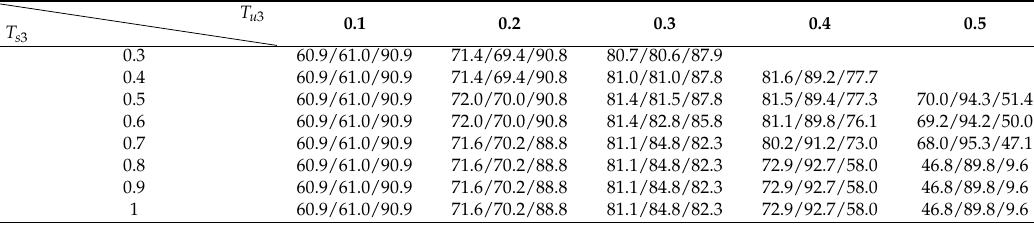
Table 4. Overall accuracy (%)/user’s accuracy (%)/producer’s accuracy (%) as a function of T s 3 and T u 3 . T s